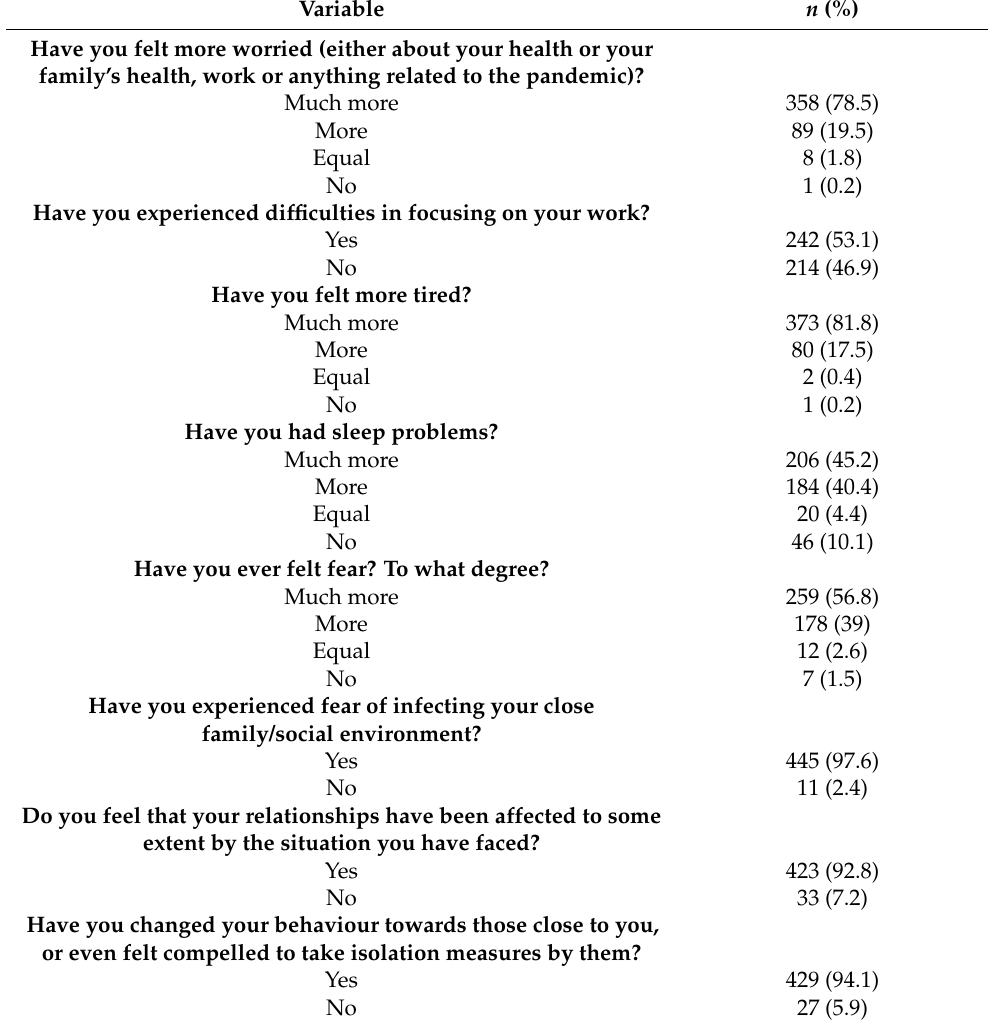
Table 2. Thoughts and feelings during the pandemic ( n = 456). Variable n (%) Have you felt more worried (either about your health or your Much